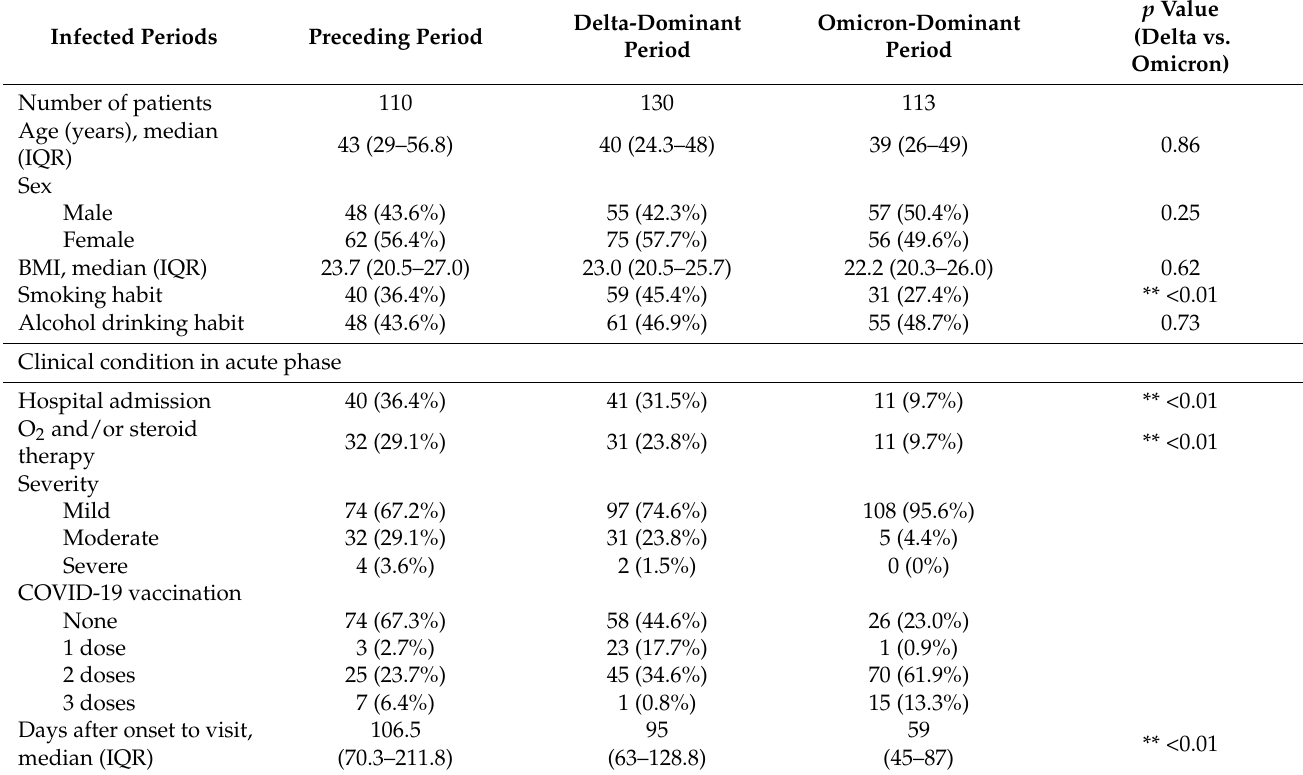
Table 1. Clinical characteristics of 353 patients with long